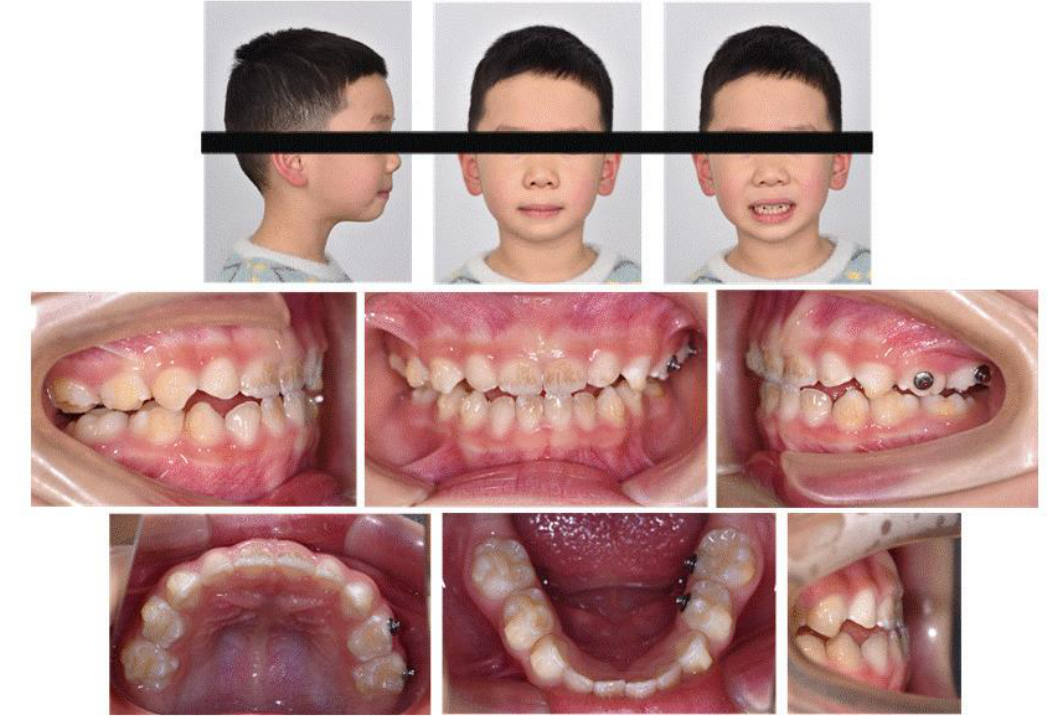
Figure 10. Intraoral photograph after the 8th aligner.